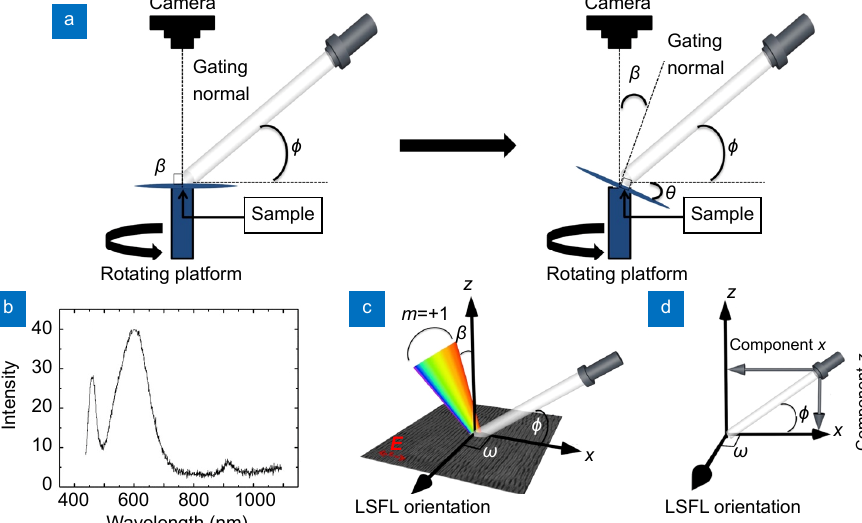
Fig. 4 | ( a ) Experimental setup and geometry used for the evaluation of surface diffraction properties. ( b ) Typical intensity plot of the white light spectrum. ( c ) Schematic illustration of the structural color monitoring system. ( d ) The respective coordination parameters.